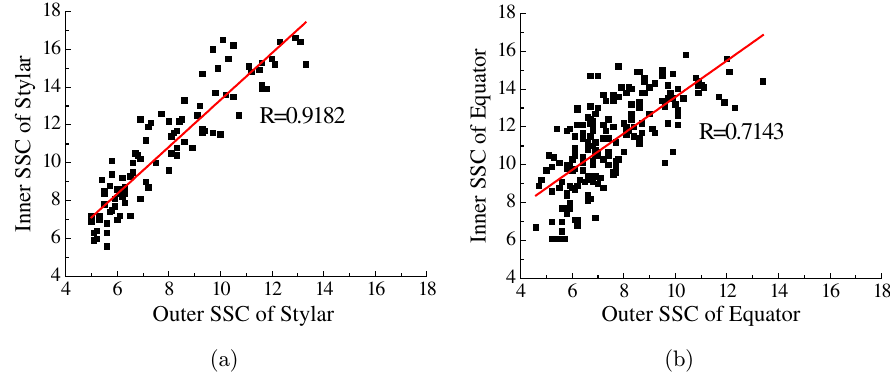
Fig. 6. The correlation between outer and inner SSC at (a) stylar and (b) Table 2. Comparison of mix-cultivars of melon SSC and ¯rmness calibration model performance developed by di®erent wavelength selection methods and PLS.